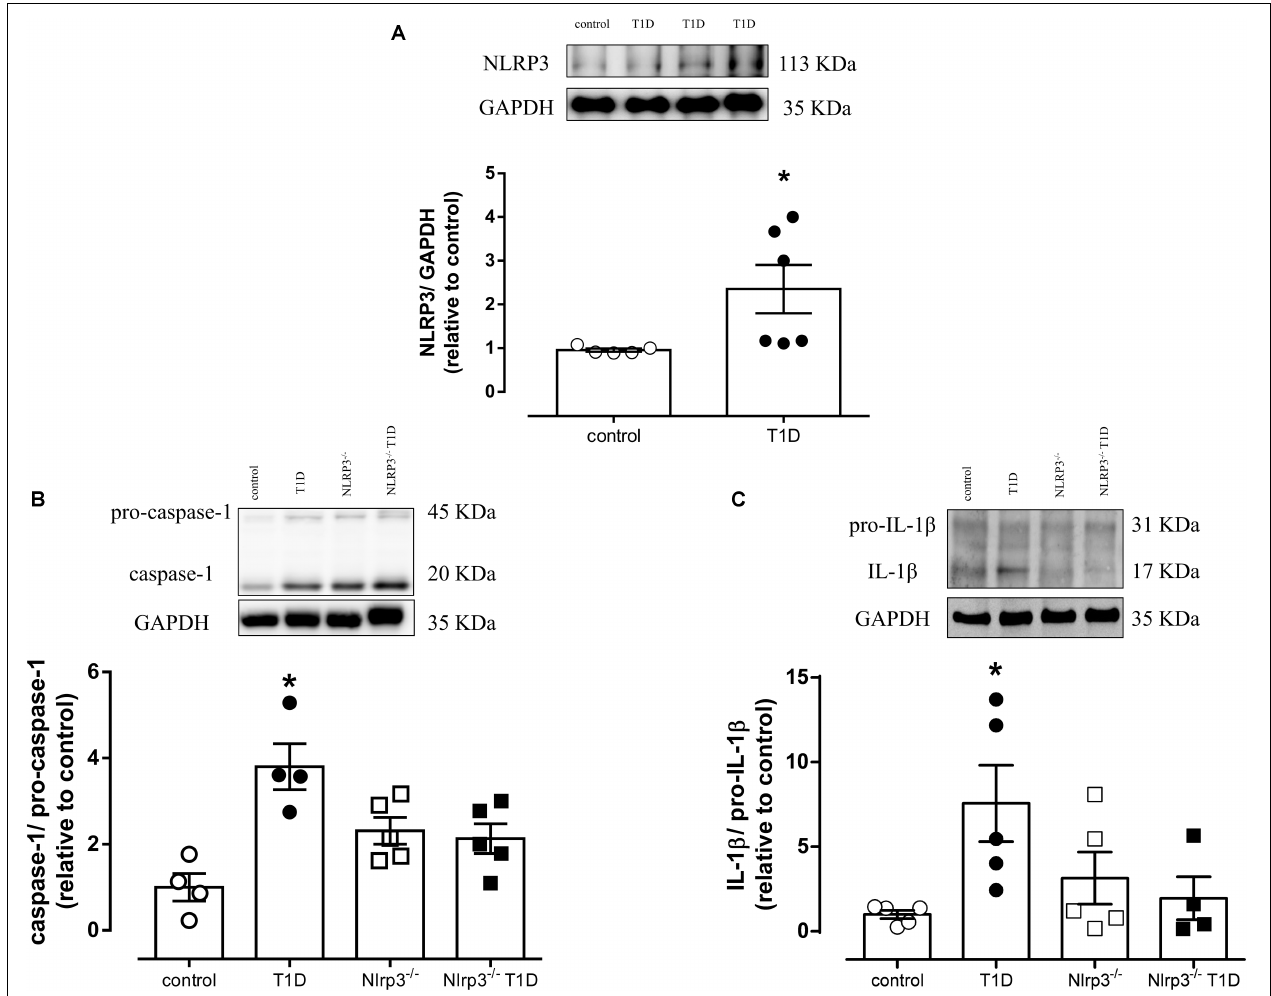
FIGURE 1 | On top, representative images of western blot and, at the bottom, densitometric analysis of protein expression of (A) NLRP3, (B) caspase-1 and pro-caspase-1 and (C) IL-1 β and pro-IL-1 β in mesenteric arteries from non-diabetic (control, white circles) or diabetic (T1D, black circles) C57BL/6 mice and non-diabetic ( Nlrp3 − / − , white squares) or diabetic ( Nlrp3 − / − T1D, black squares) Nlrp3 − / − mice. Each column represents the mean ± SEM. ∗ P < 0.05 vs. control. N = 4–6, Student’s t -test (A) and two-way ANOVA followed by a Tukey’s post hoc test (B,C) .